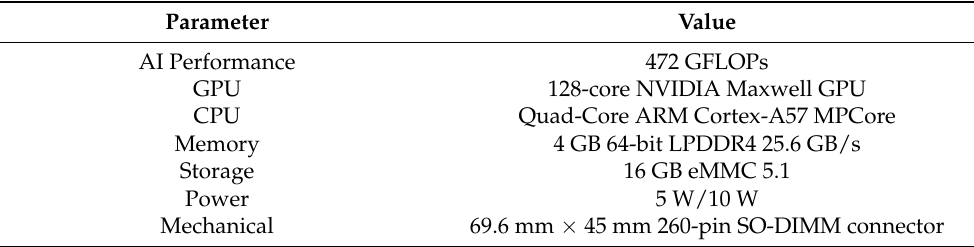
Table 2. Characteristics of the NVIDIA Jetson Nano